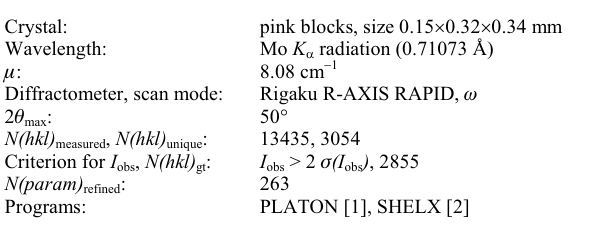
Table 1. Data collection and handling.